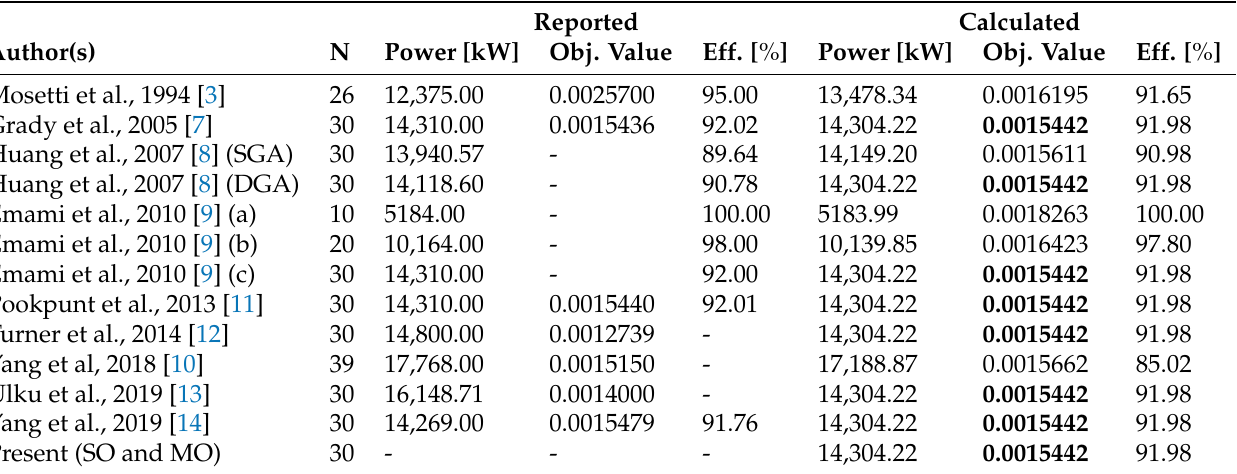
Table 3. Results comparison for case